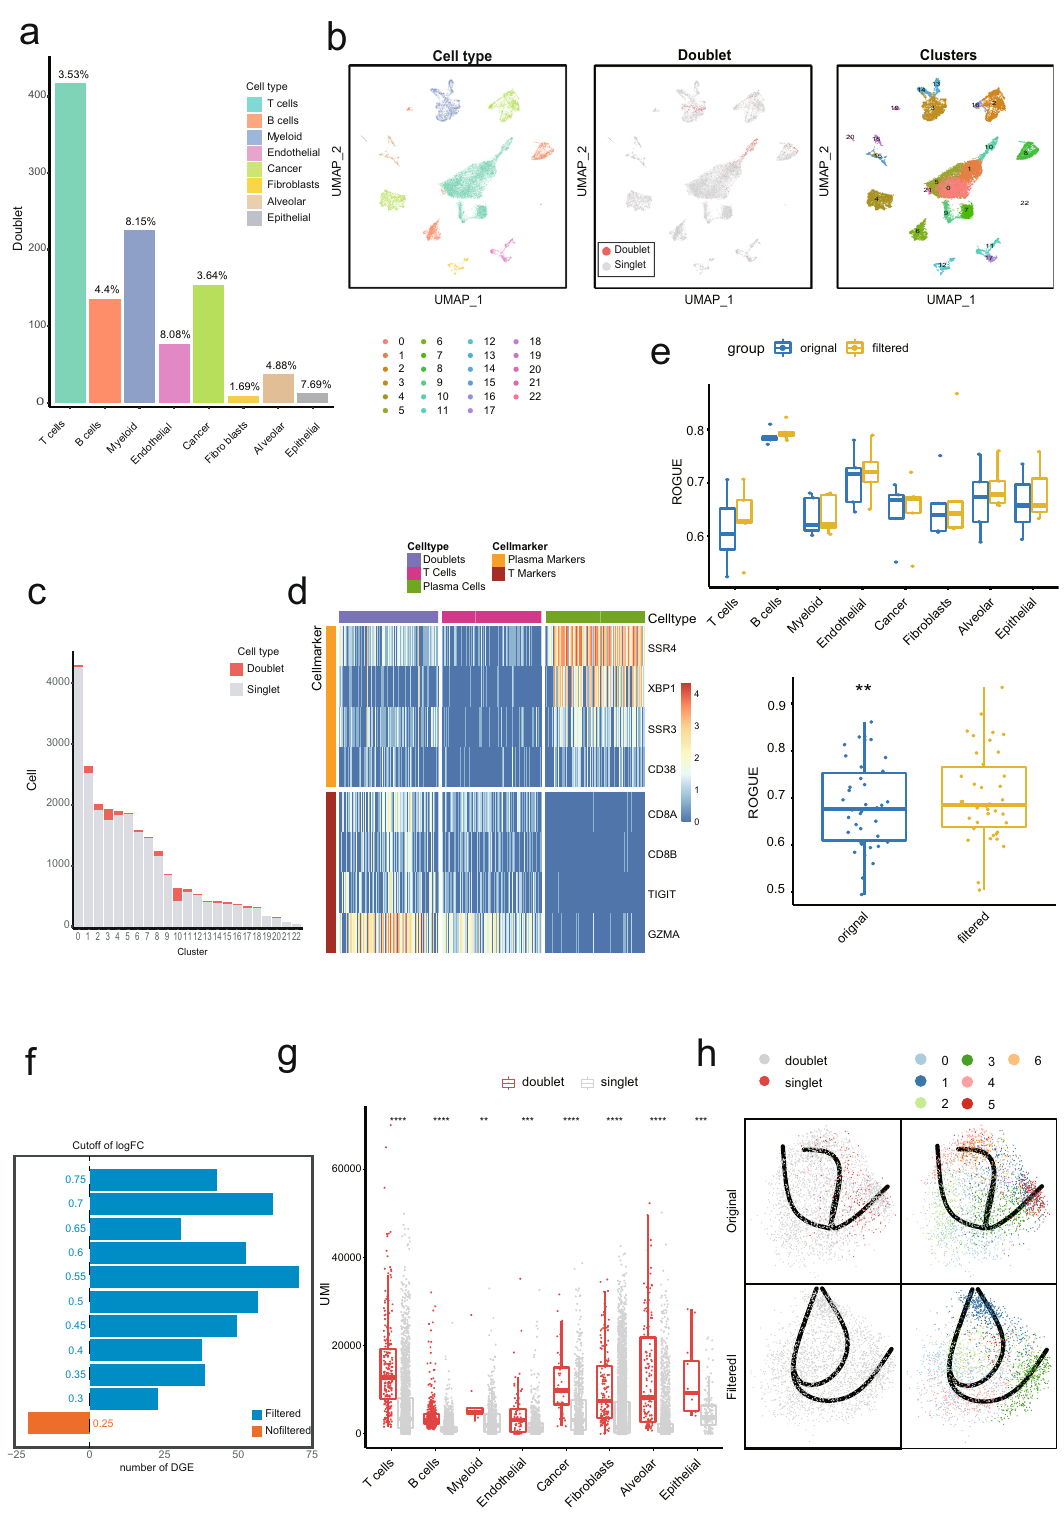
for the simulated datasets on the same computer server (E5-2678v3 CPU processor and 256 GB memory) was recorded. Base analysis process for lung cancer data . We obtained the Seurat object from SCope (https://gbiomed.kuleuven.be/scRNAseq-NSCLC) including 19 samples from fi ve